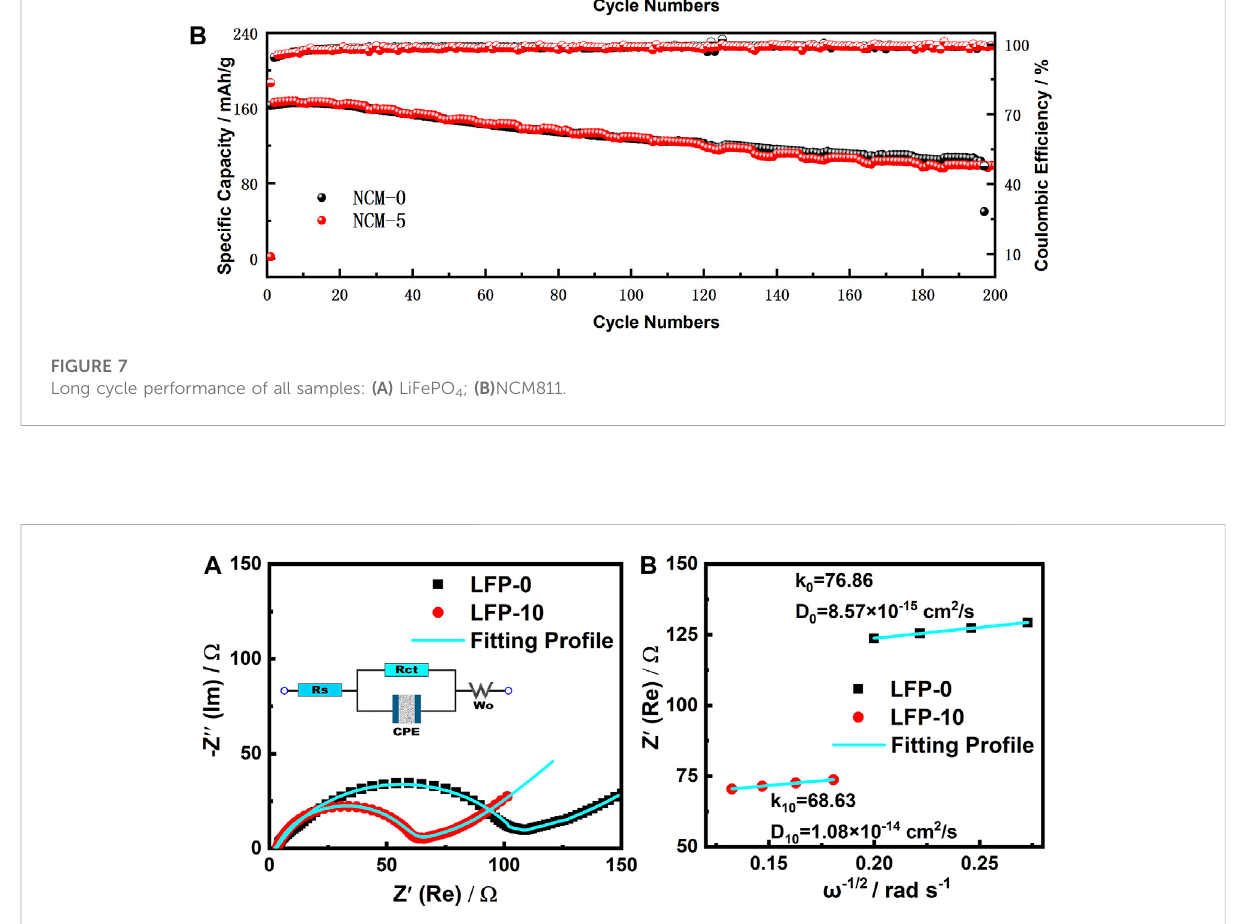
the Li + movement and here takes the value of 1, S is the improves the cycle life of LiFePO 4 . The D Li + of the cathode is calculated using Formula 2, and the results are shown in effective contact area between the electrode and the Figure 9B. electrolyte, D Li + is the diffusion coef fi cient, v is the preset sweep rate, and C Li is the lithium-ion ) I (cid:2) 2 . 69 × 10 5 n 3 / 2 SD 1 / 2 v 1 / 2 C p Li (2 Li + concentration in the cathode. As shown in Figure 9B, the D Li + of LFP-0 is 3.66 × 10 – 14 cm 2 /s, while the D Li + of the where I p is the peak current of the oxidation peak in the CV LFP-10 cathode after doping and modi fi cation increased to curve, n represents the number of electrons transferred by